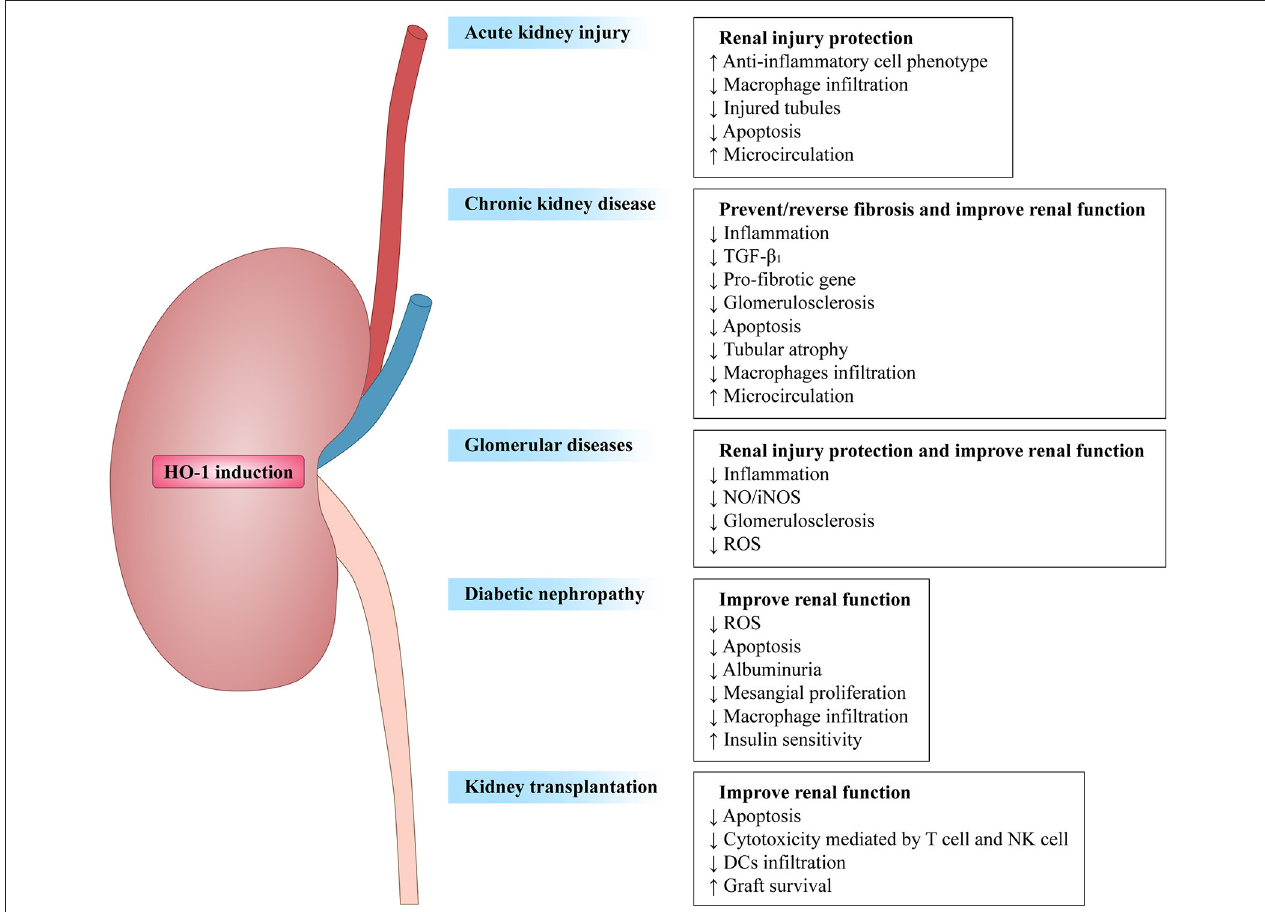
FIGURE 2 | Overview of heme oxygenase-1 in renal diseases. HO-1 induction prevents renal damage in diverse renal diseases, such as acute kidney injury (AKI), chronic kidney disease (CKD), glomerular diseases, diabetic nephropathy (DN), and kidney transplantion. Arrows followed by text indicate increase ( ↑ ) or decrease ( ↓